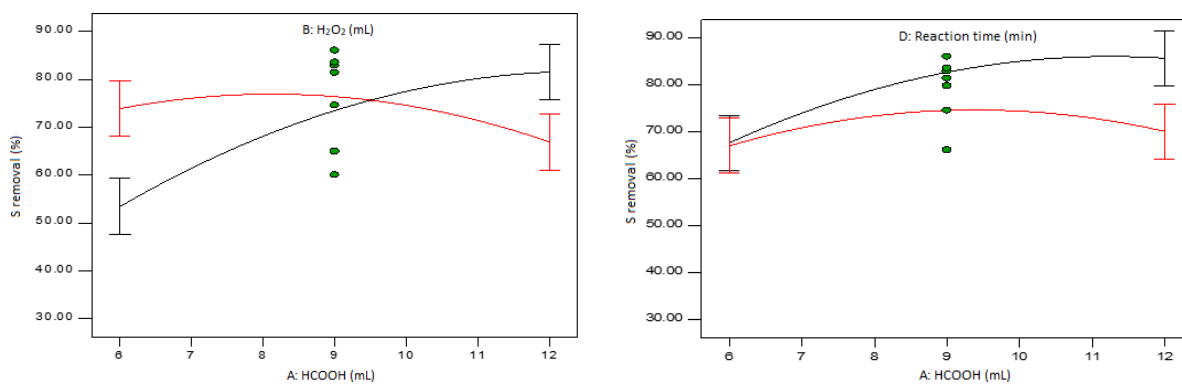
Figure 6: Interaction plot of formic acid and hydrogen peroxide amounts at mid-level temperature and reaction time.